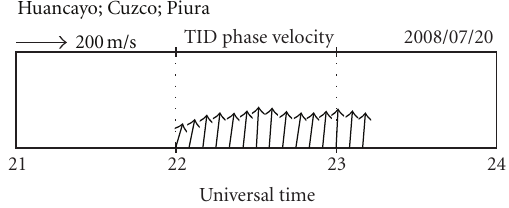
Figure 10: Same as Figure 7, but for TID’s phase velocities that were calculated using TECP values from Huancayo, Cuzco, and